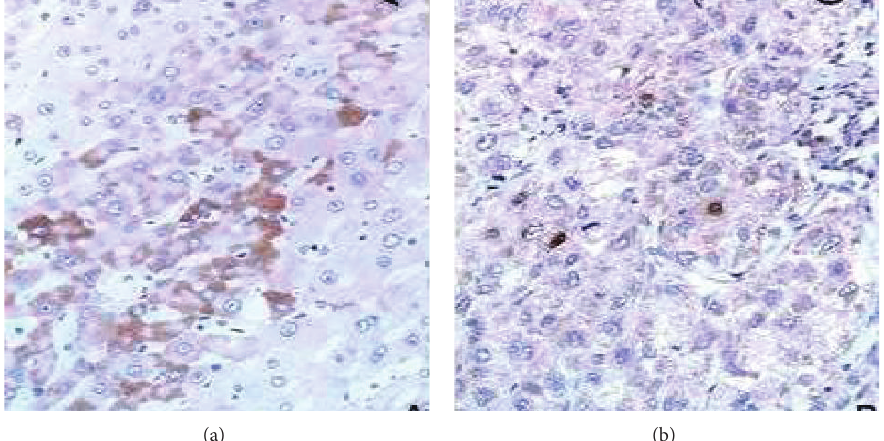
Figure 2: HBsAg and HBcAg expression in HCC tissues. (a) HBsAg expression in the cytoplasm; (b) HBcAg expression in the cell nucleus. IHC stain, magnification × 200.